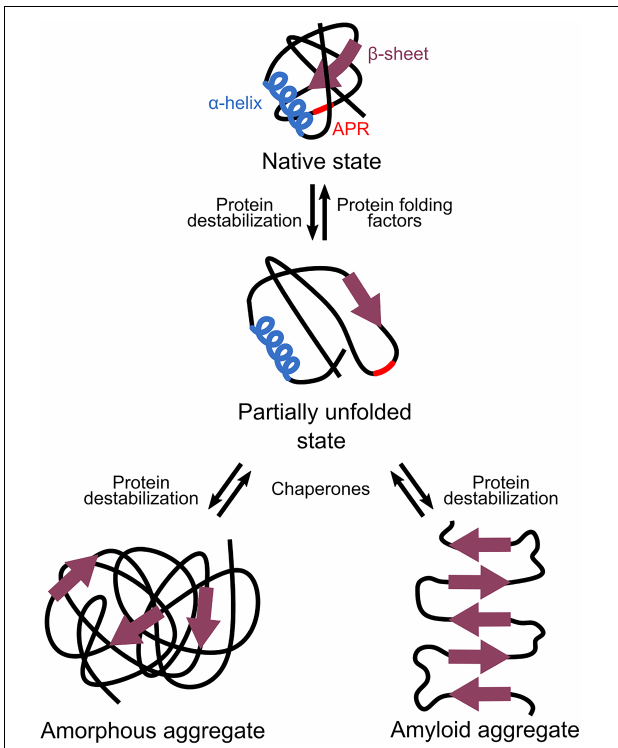
FIGURE 2 | Different types of protein aggregations. When proteins are—at least partially—unfolded or misfolded, they can expose their aggregation-prone regions (APRs). Interaction of APRs of different proteins results in the formation of intermolecular β -sheets that cause aggregation. Amyloid aggregates are highly ordered as their β -sheets run perpendicular to the central axis of the aggregate. Amorphous aggregates also contain some β -structures but lack this long-range